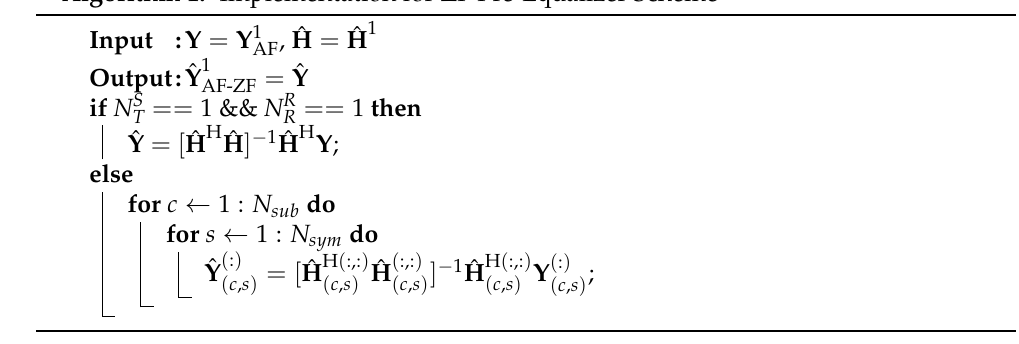
Algorithm 1: Implementation for ZF Pre-Equalizer